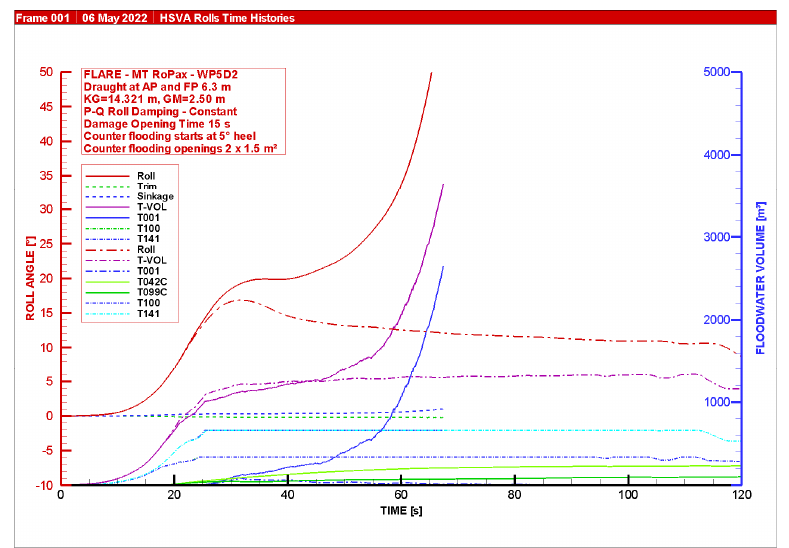
Figure 6. Counter flooding with damage opening time 15 s: The roll angle (red) and water volumes on trailer deck and in damaged compartments (bluish) and in those for counter flooding (green) are shown. T ‐ VOL is the total volume of the floodwater in ship, and T001 is the water volume on the trailer deck.